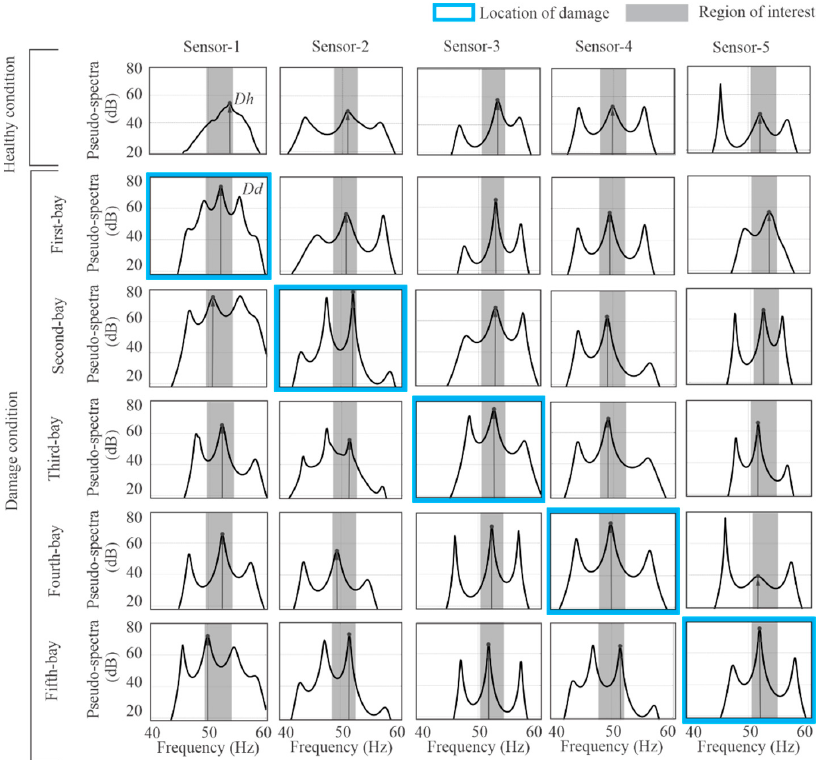
Figure 12. Pseudo-spectra obtained from the EC scenario and used to identify condition–location of damage.